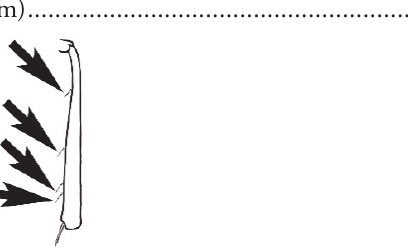
In profile, propodeal dorsum of minor and media workers extremely narrow and almost acuminate; metanotal groove in all workers narrowly and deeply impressed; mesonotum of minor worker hypertrophied so that metathoracic spiracle is situated on its underside in a distinctly lateral position; all workers with weak pubescence and a moderate number of erect setae on